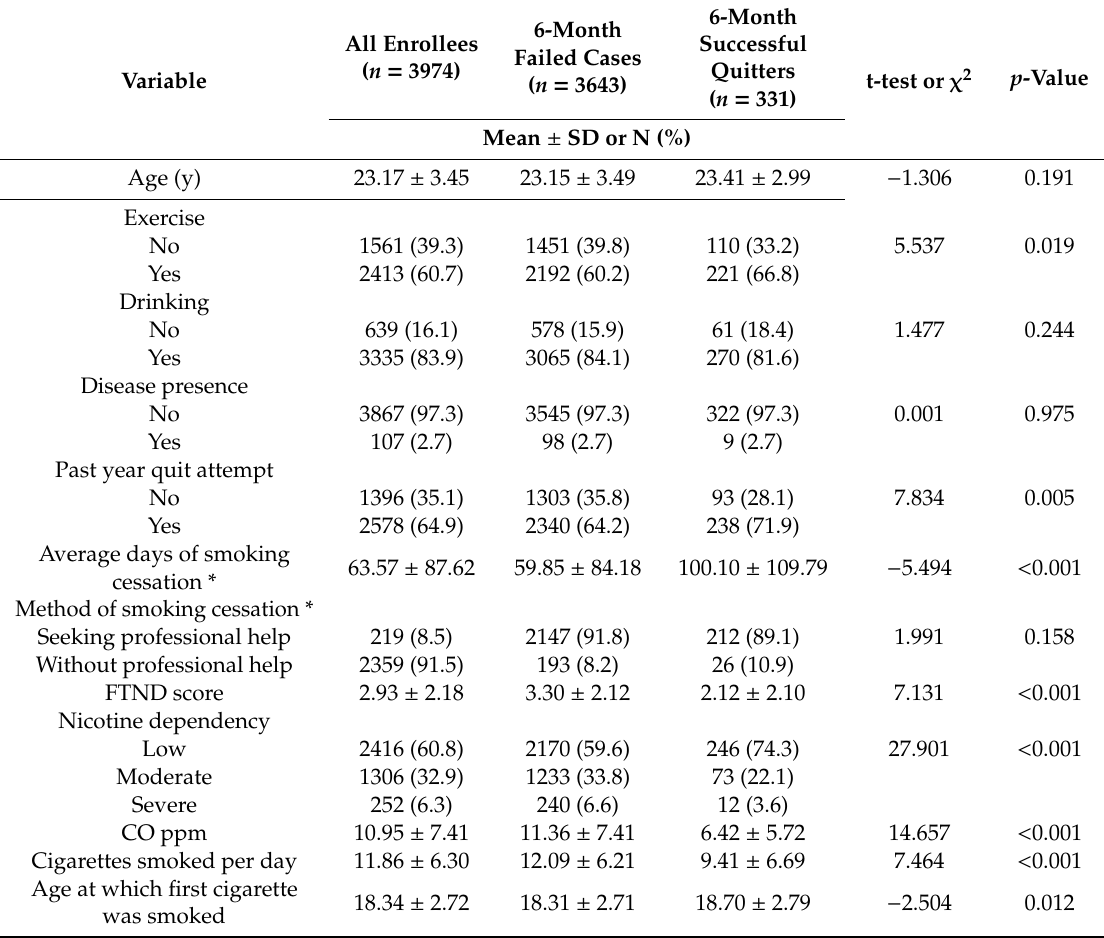
Table 2. Baseline characteristics of college-going smokers in the Visiting Smoking Cessation Services Program in Korea, 2015 to 2017 ( N =